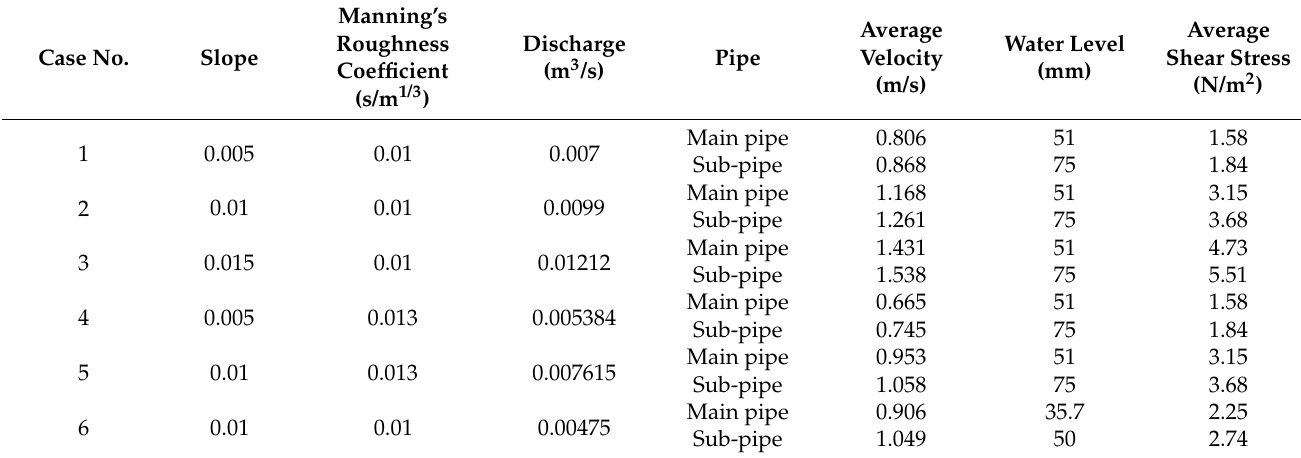
Table 3. CFD results of circular pipe and complex cross-section pipe ( D main-pipe : 450 mm, D sub-pipe : 150 mm).